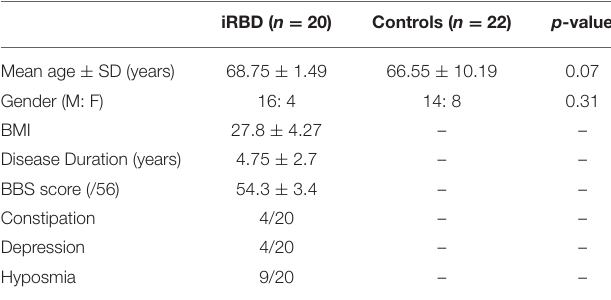
TABLE 1 | Demographic and clinical characteristics of the iRBD and control